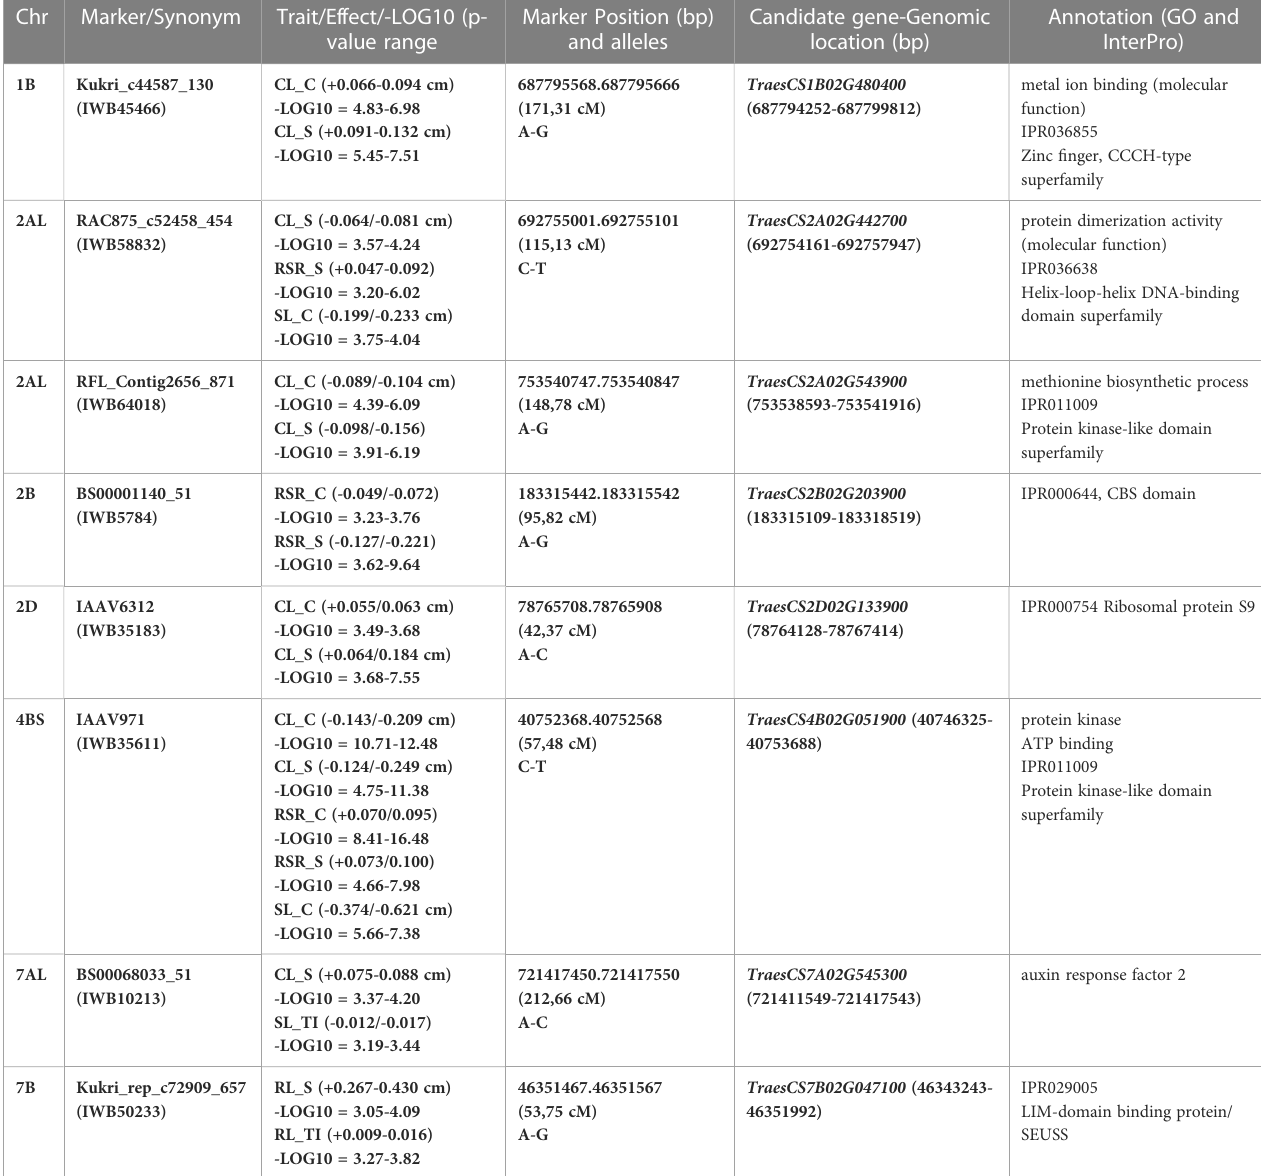
TABLE 2 Distribution of pleiotropic loci or QTN (quantitative trait nucleotides) and candidate genes associated with two or more traits related to seedling growth under drought and control conditions. Chr Marker/Synonym Trait/Effect/-LOG10 (p- Marker Position (bp) value range and